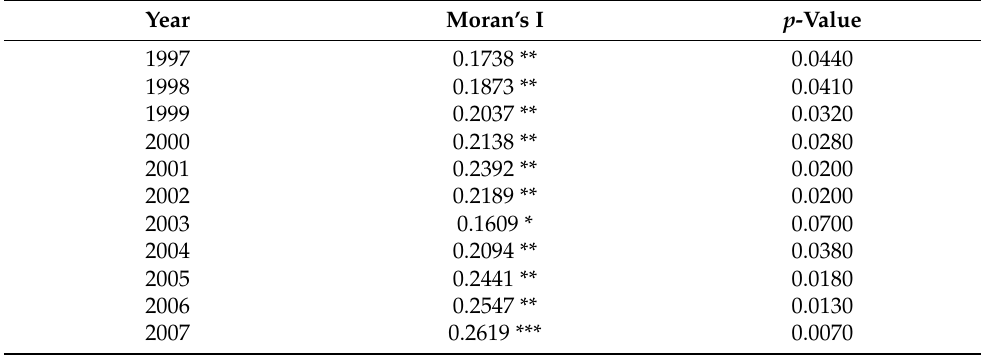
Table 14. Moran’s I of Carbon Emission from 1997 to 2015 in